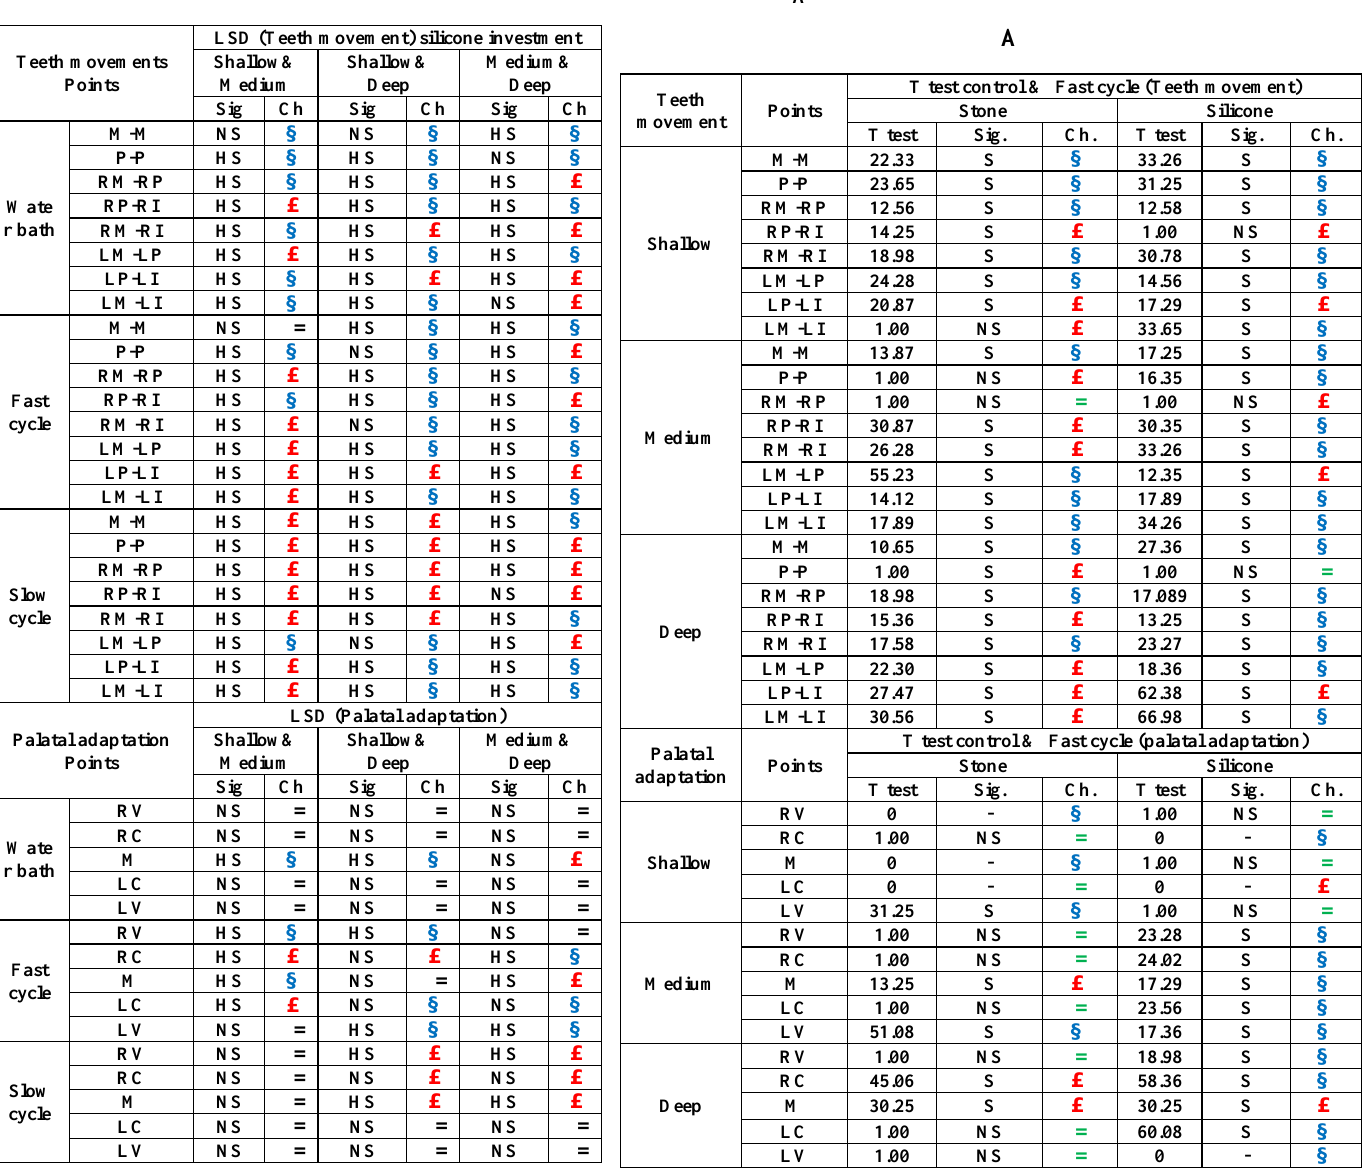
Table 5: T test for comparison between A:control and fast autoclave curing cycles, B: Control and slow autoclave curing cycles, C: Fast and Slow autoclave curing cycles for palatal depths and investment